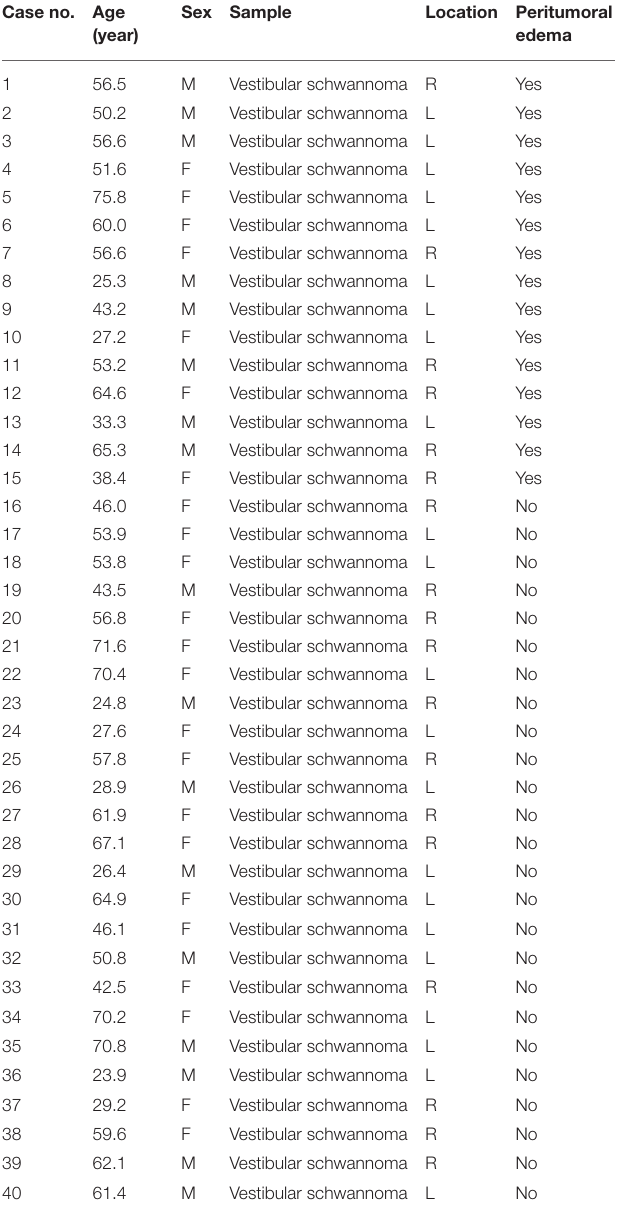
TABLE 1 | Clinical data obtained for each of the 40